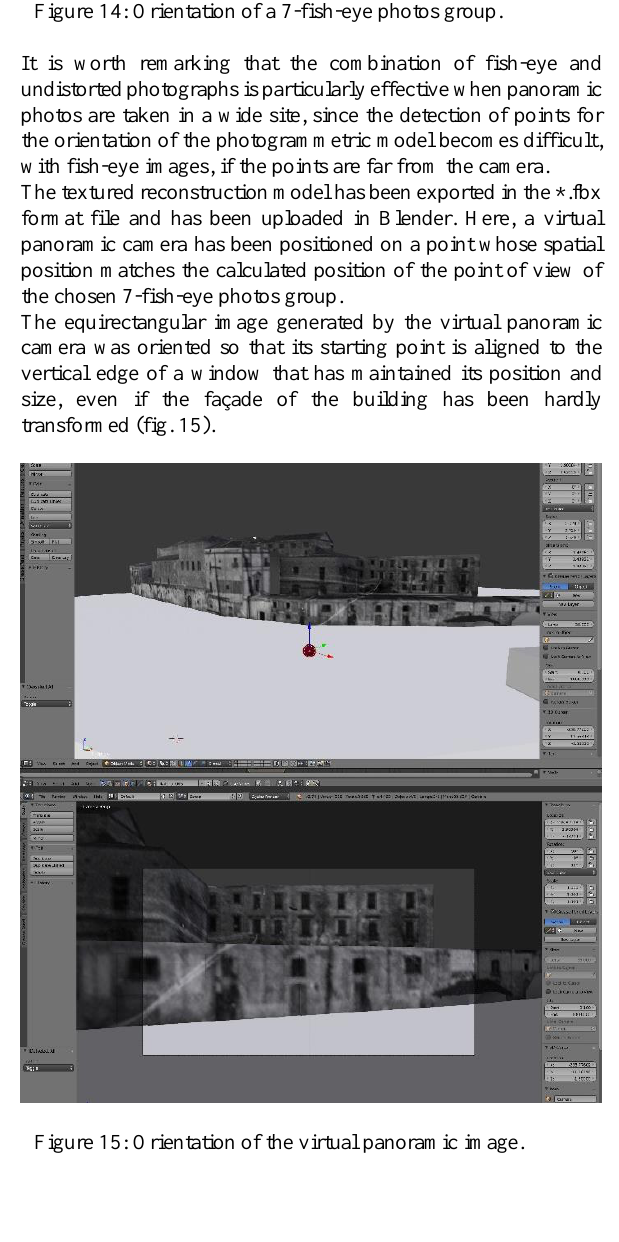
Figure 14: Orientation of a 7-fish-eye photos group.